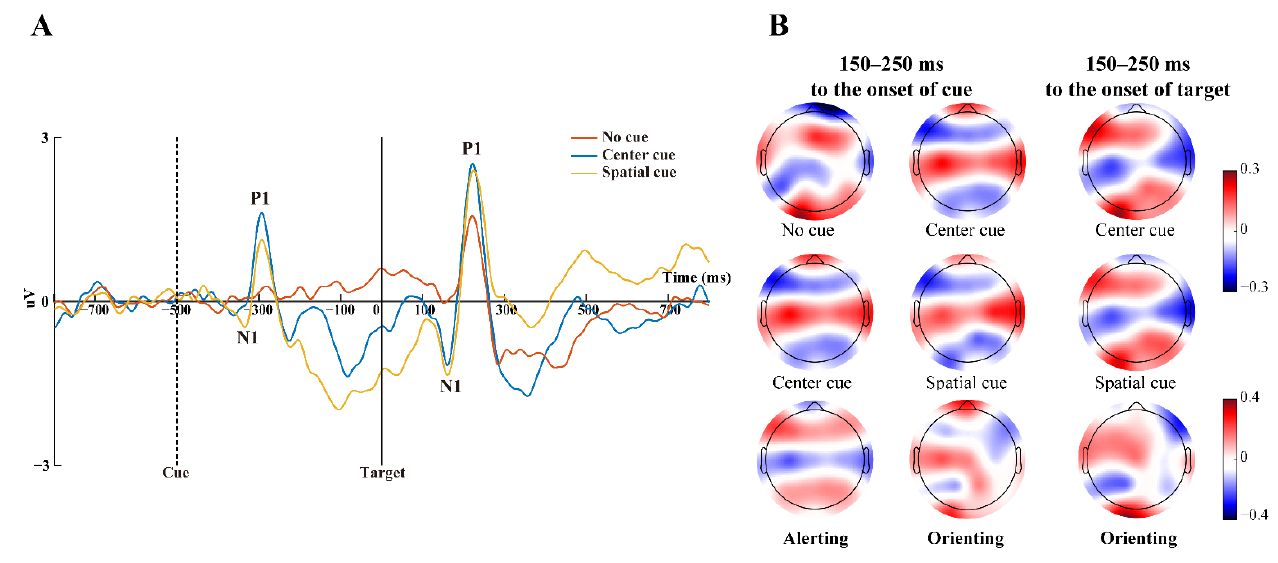
Figure 5. ERP waveforms and CSD topographical maps of each cue condition and two attention network effects: ( A ) grand average ERP waveforms stratified by cue and target conditions on electrodes POz, PO4, O1 and Oz. Cue stimulus onset is at − 500 ms (dash line) and target stimulus onset is at 0 ms (solid line); ( B ) 2D top view of mean CSD maps of two attention network effects within 150–250 ms after cue and target onset. CSDs of alerting (bottom row) was obtained by subtracting averaged ERP of center cue condition (middle row) from no cue condition (top row), and orienting (bottom row) was obtained by subtracting averaged ERP of spatial cue (middle row) condition from center cue condition (top row). Units are µ V/m 2 .